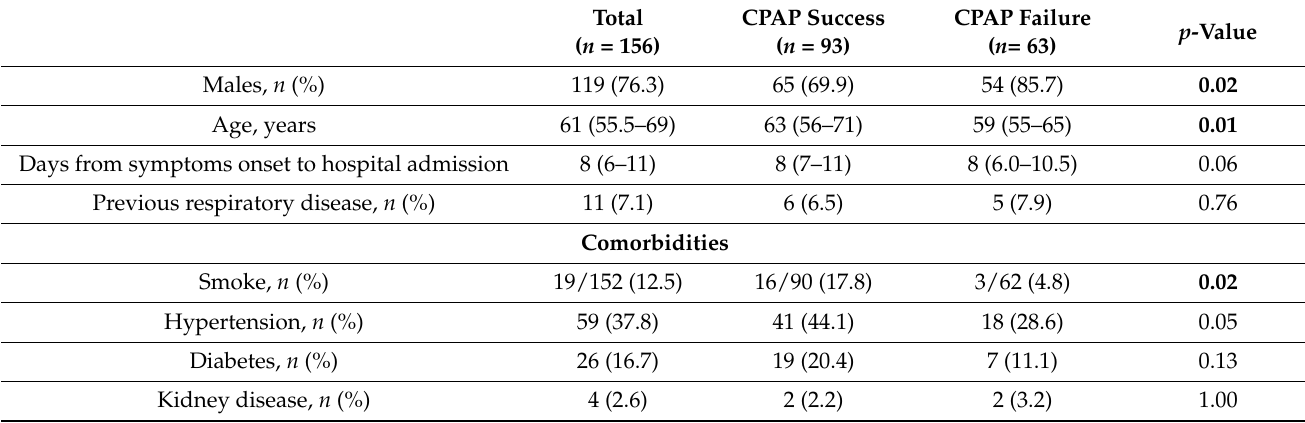
Figure 1. A schematic overview of the studied population. CPAP = continuous positive airway pressure; NIV = noninvasive ventilation; DNR = “do not resuscitate” order; DNI = “do not intubate” order. Table 1. Clinical characteristics of the study cohort and of patients that failed and succeeded